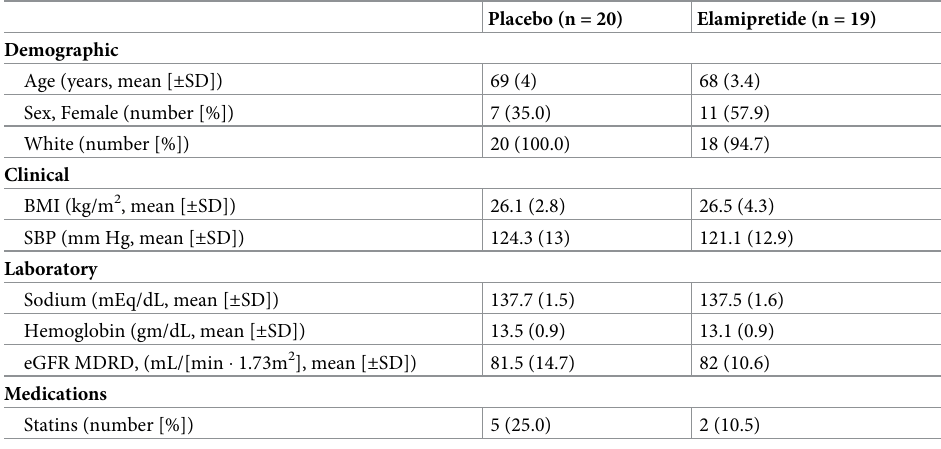
Table 1. Baseline characteristics of study